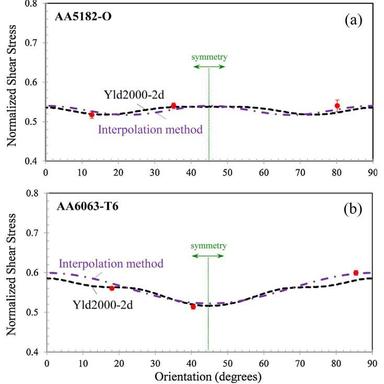
11. Normalized shear stress in different orientations with respect to the rolling direction for (a) AA5182-O and (b) the extrusion direction for AA6063-T6. Red symbols show the experimental data.